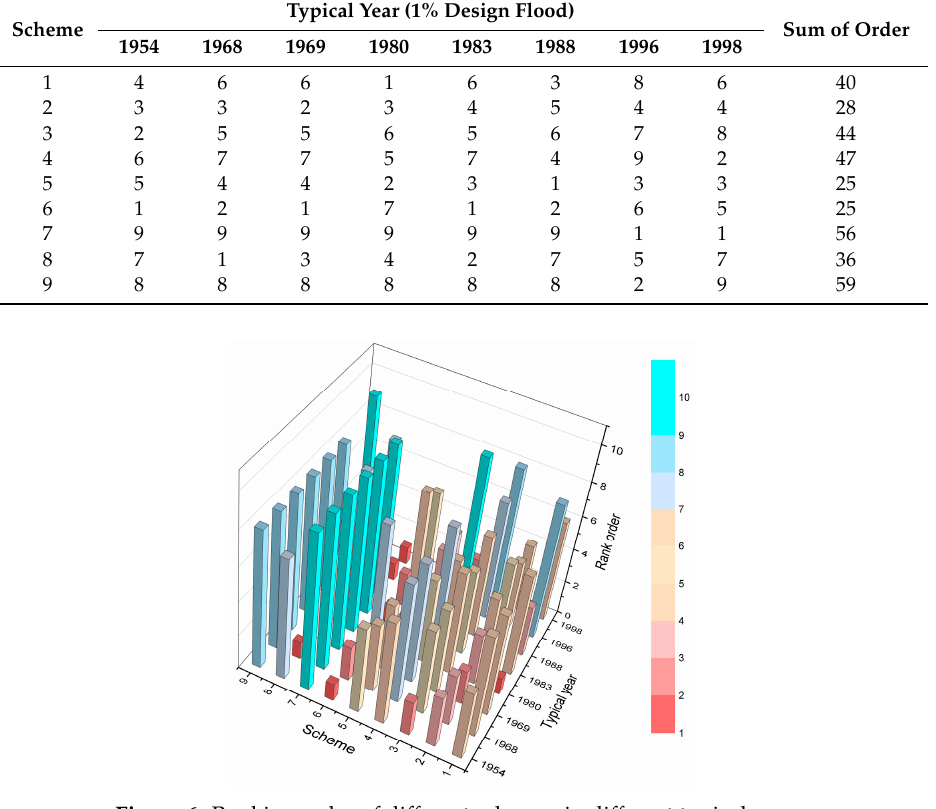
Figure 6. Ranking order of di ff erent schemes in di ff erent typical years.